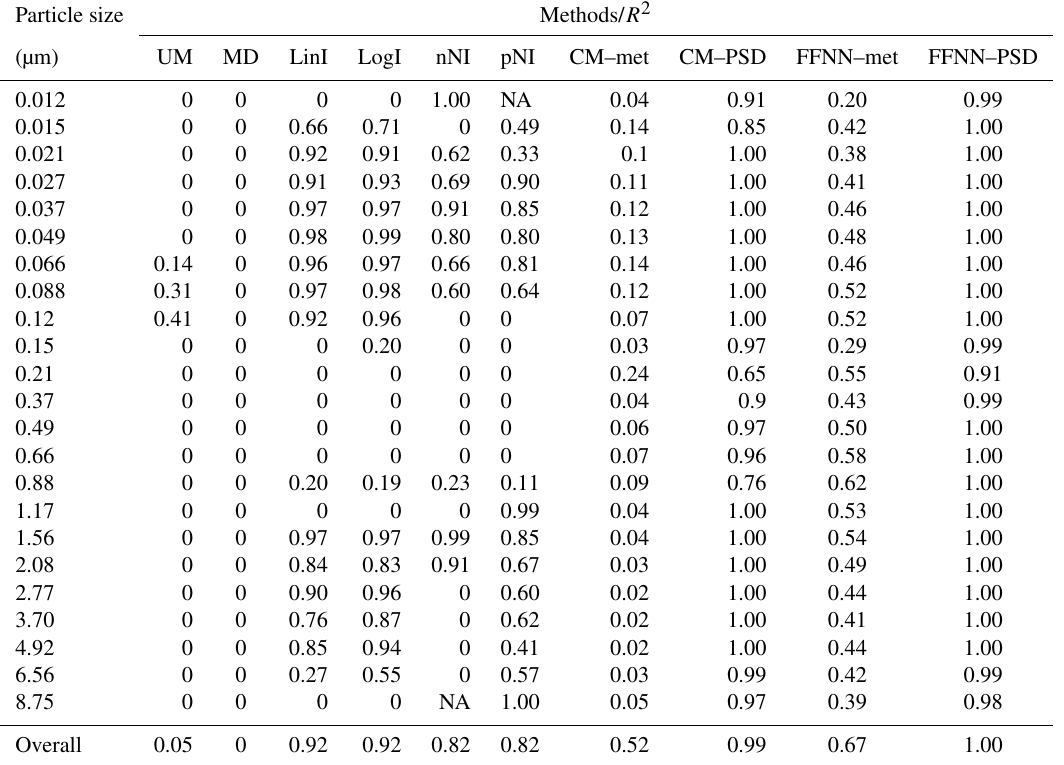
Table 3. Table showing the comparison of different estimation methods, including unconditional mean (UM, column 2), median (MD, col- umn 3), linear interpolation (LinI, column 4), logarithmic interpolation (LogI, column 5), next-neighbour interpolation (nNI, column 6), previous-neighbour interpolation (pNI, column 7), and conditional mean by regression of meteorological parameters and other particle size number concentrations as inputs (CM–met and CM–PSD, columns 8 and 9, respectively) and the feed-forward neural network with meteo- rological parameters and other particle size number concentrations as inputs (FFNN–met and FFNN–PSD, columns 10 and 11, respectively). The coefficient of determination ( R 2 ) of each method is listed for different size bins on each row. Negative R 2 values are represented by “0” to indicate poor accuracy at the particular particle size bin, while “NA” means the data are not available. The last row concludes the overall evaluation